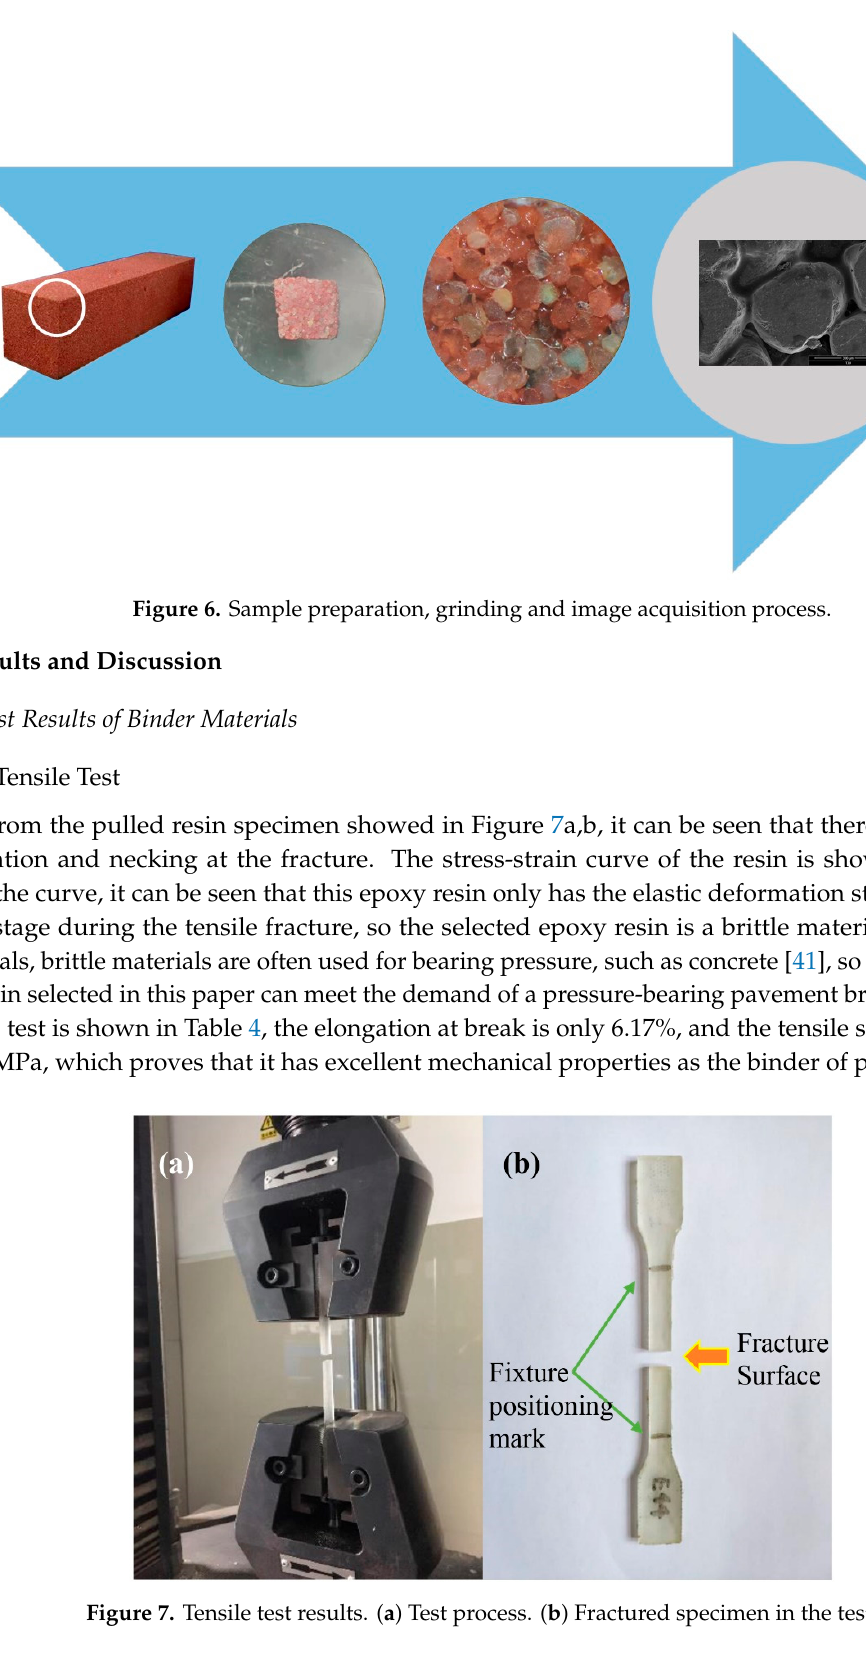
Figure 8. Stress-strain curve of resin specimen. 3.1.2. DMA Dynamic mechanical indexes of bisphenol-A epoxy resin can be obtained by dynamic mechanical analysis, such as storage modulus (E ′ ), which indicates the elasticity of epoxy resin, and loss modulus (E ″ ), which indicates the plasticity of epoxy resin, glass transition temperature (Tg) and loss factor ( tanδ ), as shown in Figure 9.